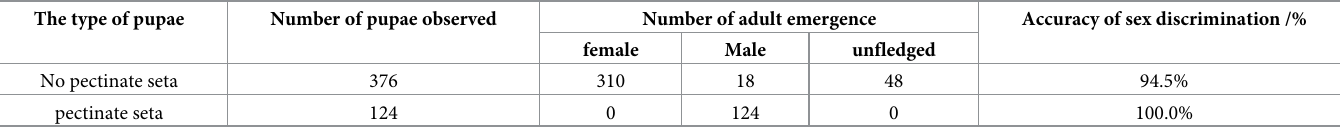
Table 1. Identification results of male and female